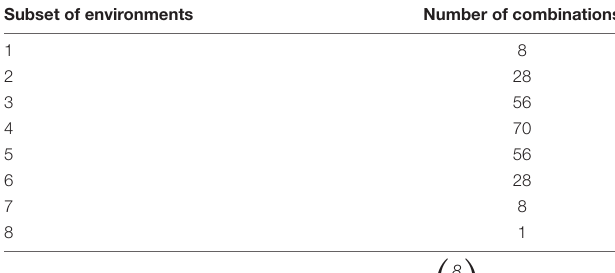
In summary, the value of the right column of the i th row is